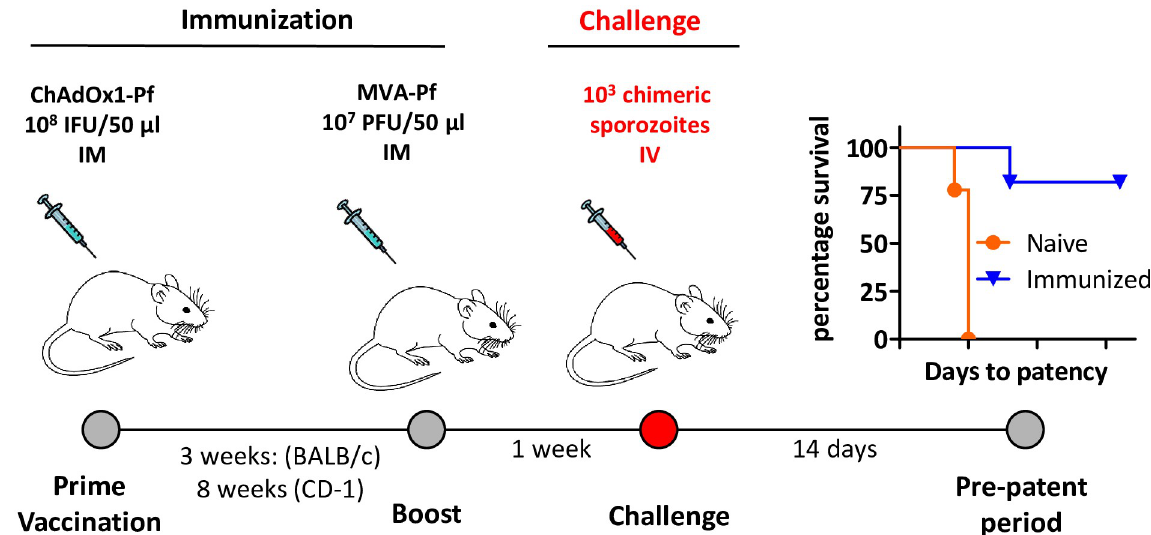
Fig 2. Schematic representation of the immunization and challenge protocol. BALB/c and CD-1 mice were immunized with ChAd63- and MVA viral-vectored P . falciparum proteins using a prime boost protocol followed by challenge with 1x10 3 chimeric P . berghei sporozoites expressing P . falciparum proteins. The plot on the right shows visualization of the number of na ï ve or immunized mice that show no or protected immunity (either no blood stage infection or delay in the pre-patency) after challenge with the chimeric parasite expressing the cognate antigen. Protective immunity is determined by measuring the day to blood stage patency i . e ., the day to reach 1% parasitemia.